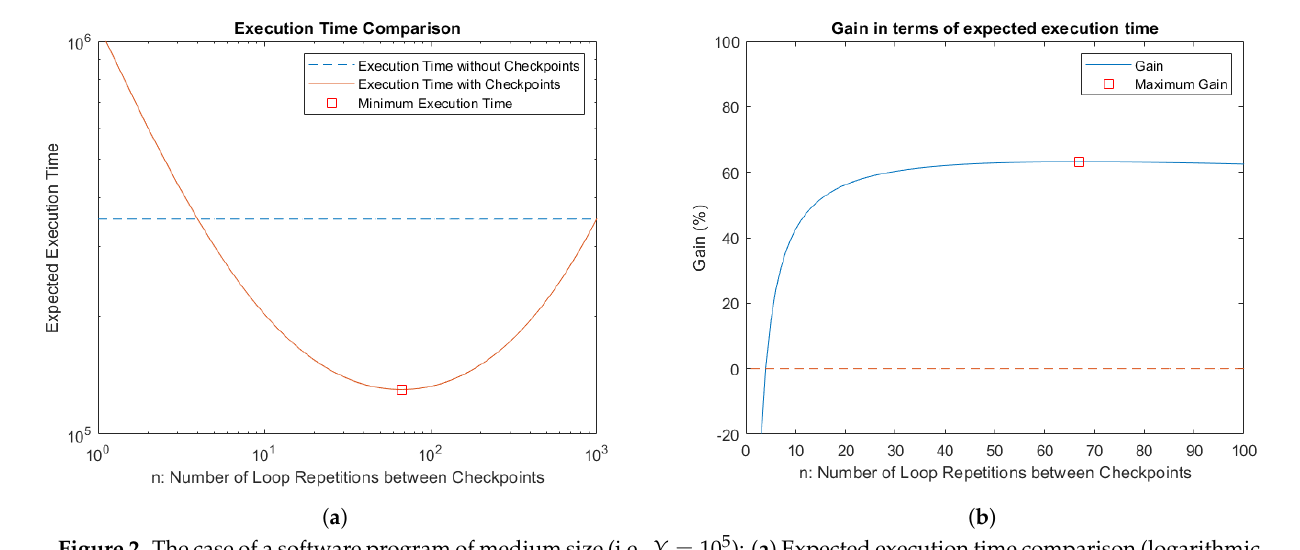
Figure 2. The case of a software program of medium size (i.e., Y = 10 5 ): ( a ) Expected execution time comparison (logarithmic axes) ( b ) Expected execution time gain.